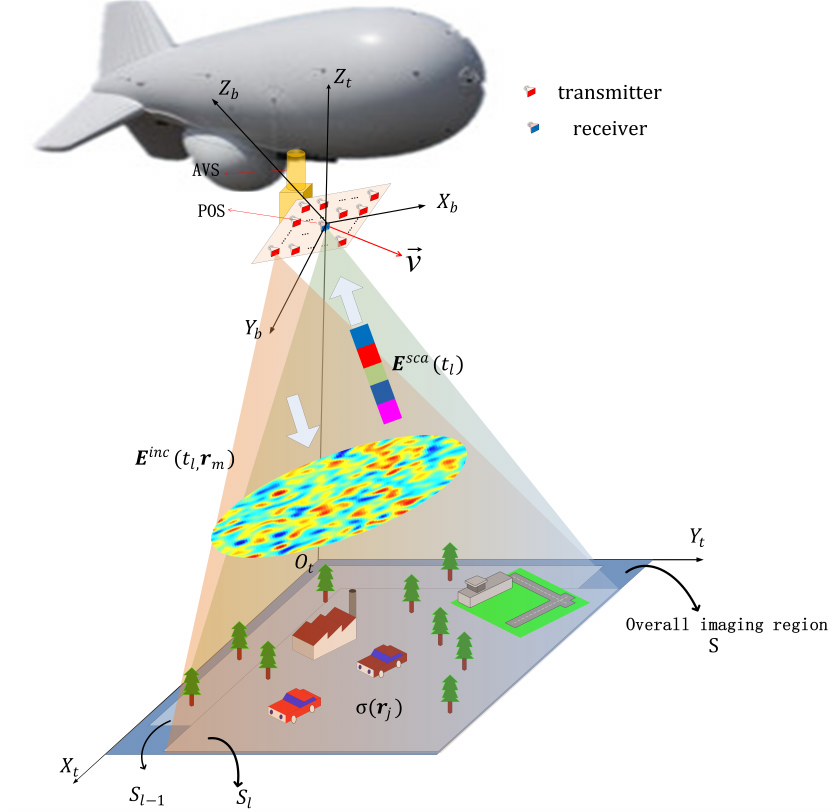
Figure 1. Imaging geometry of MSCI based on unsteady aerostat